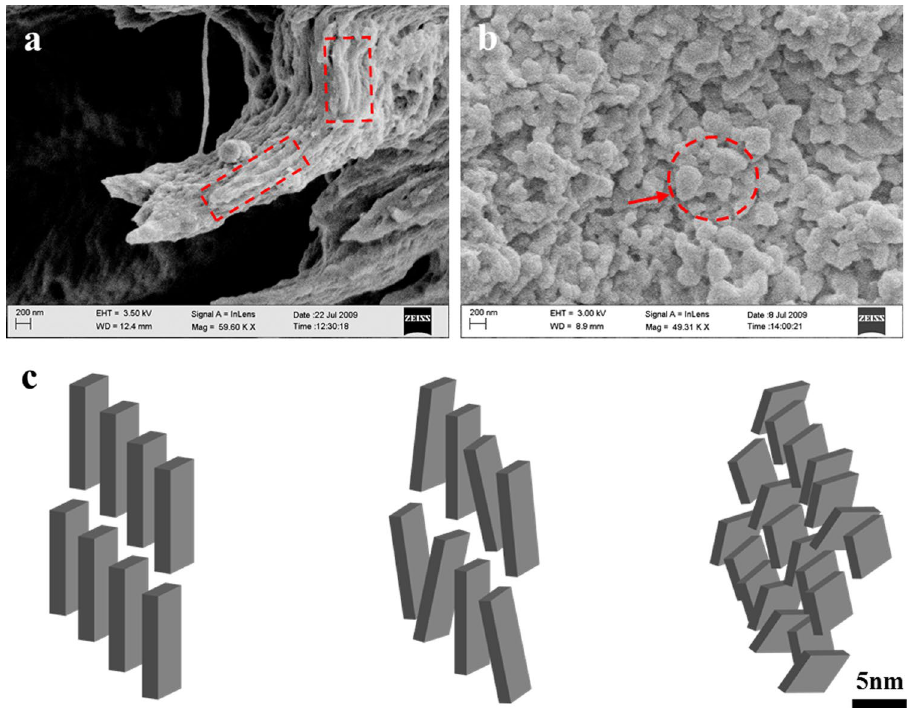
Figure 4. High magnification SEM images of ( a ) WT and ( b ) OC-OPN − / − ; − / − mice showing mineral organization. ( c ) Schematic of crystal arrangement in WT (left), OPN − / − (center) and OC − / − , OC-OPN − / − ; − / −